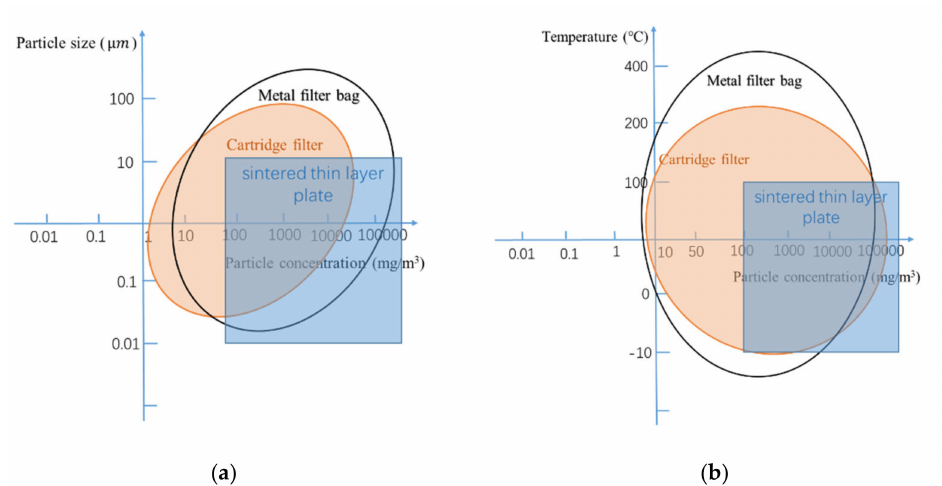
Figure 8. Area map of dry-type dust collectors in terms of particle size, filtration temperature, and concentration space. ( a ) Area map of dry-type dust collectors in terms of particle size and concentration space. ( b ) Area map of dry-type dust collectors in terms of filtration temperature and concentration